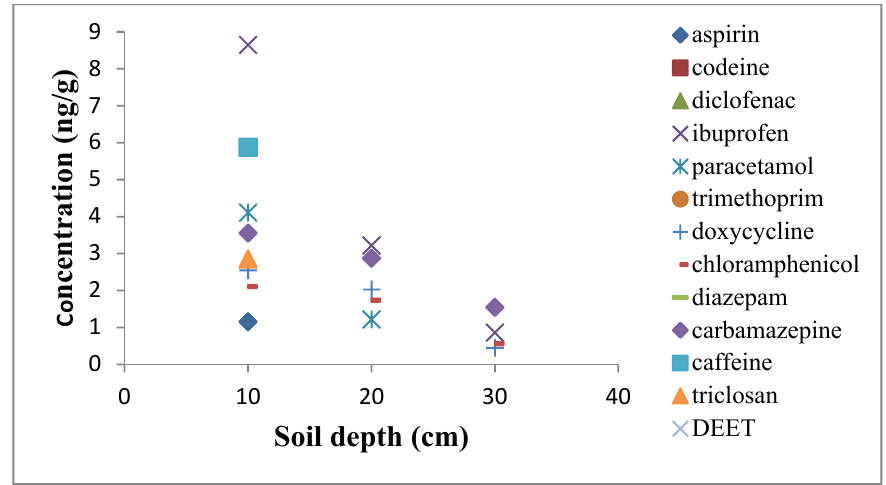
Figure 3. Box and whisker plot represents the mean concentration range (lowest, 25 percentile, median, 75 percentile and highest) of the PPCPs in the three sewage sludges.